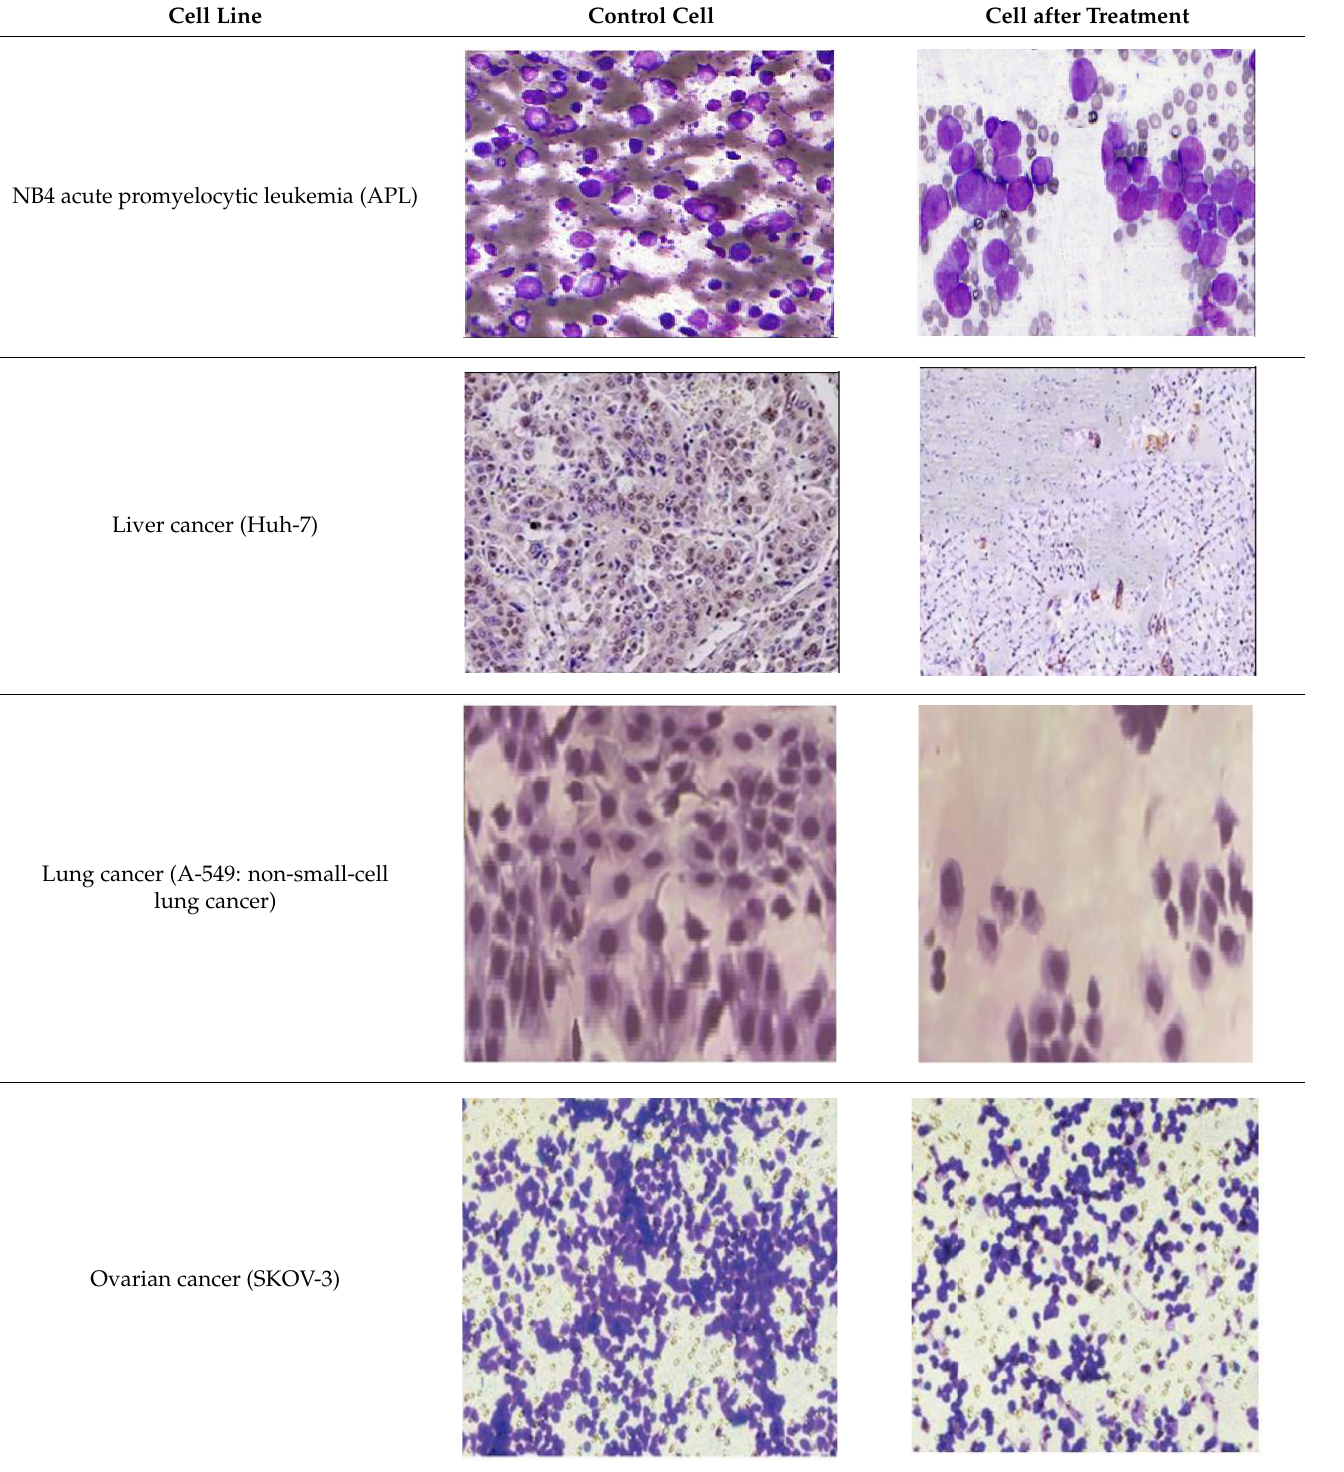
Figure 2. The inhibitory effect prism of P. amygdalus var . amara at different concentrations (5–300 µg/mL). Table 2. Microscopic examination-stained cell line study of P. amygdalus alcoholic seed extractions.